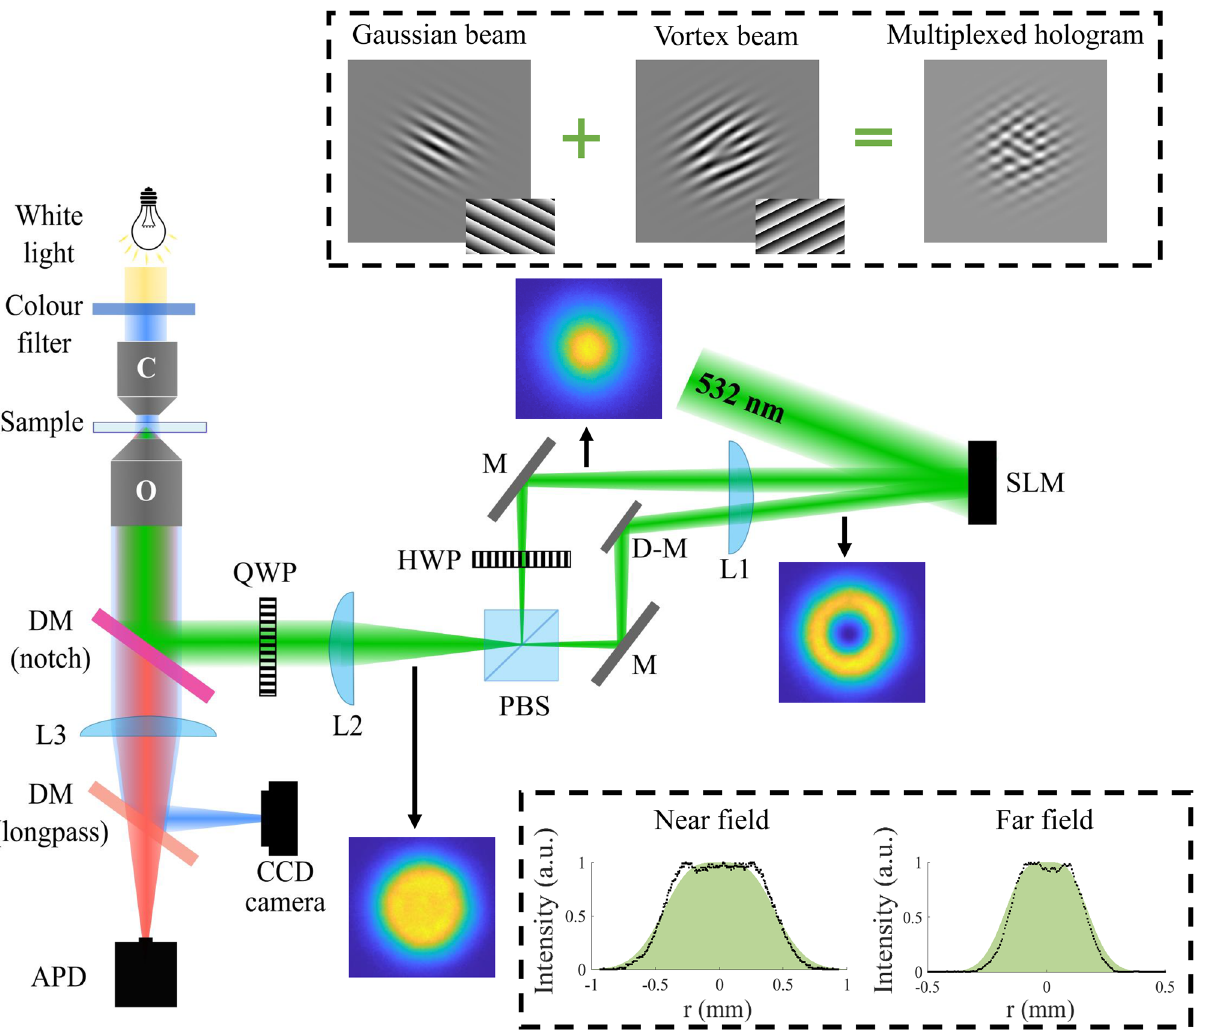
Figure 5. An illustration of the experimental setup of a vector holographic optical tweezer. The insets show the experimentally generated vortex and Gaussian beams that were combined to form the vector flat-top beam. The multiplexed hologram that was encoded on the SLM to generate a Gaussian and vortex beam with different propagation angles is shown in the top panel. The bottom panel shows the cross-section of an experimentally generated flat-top beam in the near and far field. Theoretical cross-sections are presented in green with the experimental data points in Fig. 4b: the vector flat-top beam along with Gaussian beams that have (1) the same power, (2) the same gradient force and (3) the same peak intensity as the flat-top are plotted. Firstly, in the instance when the power of the 0.75 , meaning the Gaussian beam is a stronger trap (blue line). This is expected, since two beams are equal, γ = even though the intensity gradient of the vector flat-top is steeper, the high intensity peak of the Gaussian beam 1 ), the Gaussian negates this effect. Secondly, for the two beams to have the same average gradient force ( γ = beam must have 75% of the power of the vector flat-top beam (green line). Lastly, when the two beams have the same peak intensity, that is when the power of the Gaussian is half that of the flat-top beam, then the flat-top beam trap is 1.5 times stronger than the Gaussian beam trap (orange line). Most relevant is the case when the two beams have the same gradient force; here it is clear that when the vector flat-top beam and the Gaussian beam have the same trap strength (or gradient force), the peak intensity of the vector flat-top is lower than the Gaussian beam. This means that the vector flat-top beam can be used to trap a particle with the same strength but with a lower peak intensity than the Gaussian beam. Vector HOT setup. The experimental setup of the vector holographic optical trap is illustrated in Fig. 5. An expanded and collimated Gaussian beam with a wavelength of (cid:31) = 532 nm was used to illuminate the screen of a reflective spatial light modulator (SLM, Holoeye Pluto, Germany). To create a vector flat-top beam, a Gauss- ian ( LG 0 0 ) and a vortex beam ( LG 1 0 ) with different propagation angles were created with the SLM (the insets show the 2D intensity profiles of experimentally obtained beams). The multiplexed grey-scale hologram that was